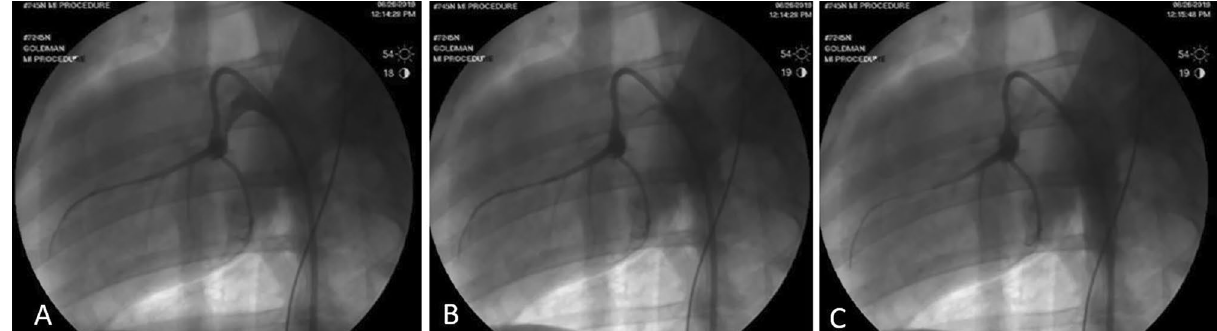
Figure 2. ( A – C ) Cardiac angiographic images in left anterior oblique (LAO) views showing placement of catheters and guide wires for induction of MI. ( A ) Guide wire with contrast agent visualizing LAD and circumflex arteries. ( B ) Deflated balloon catheter over guide wire. ( C ) Inflated balloon catheter over guide wire occluding the